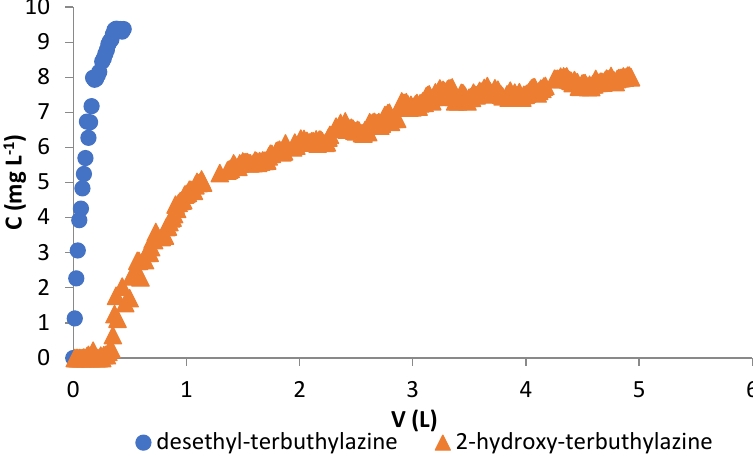
Figure 8. Adsorption breakthrough curves obtained in studied systems.